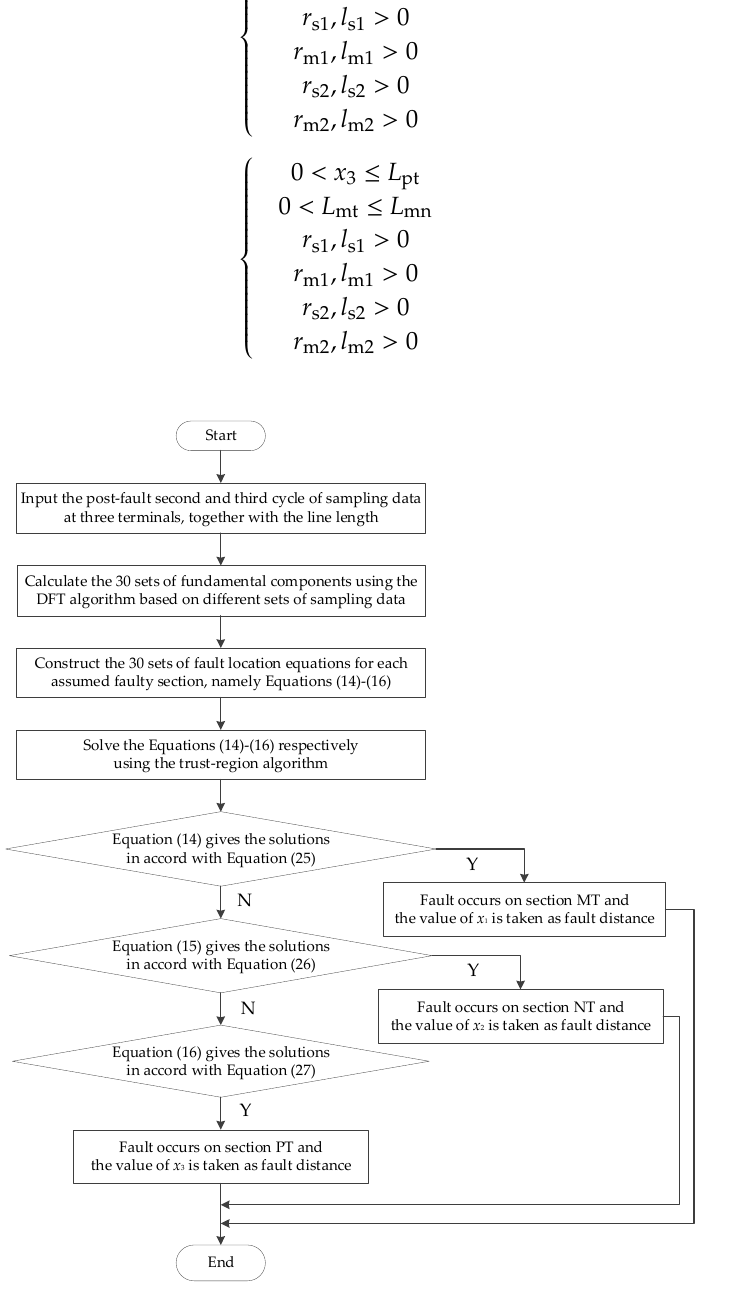
Figure 4. Algorithm flow chart.